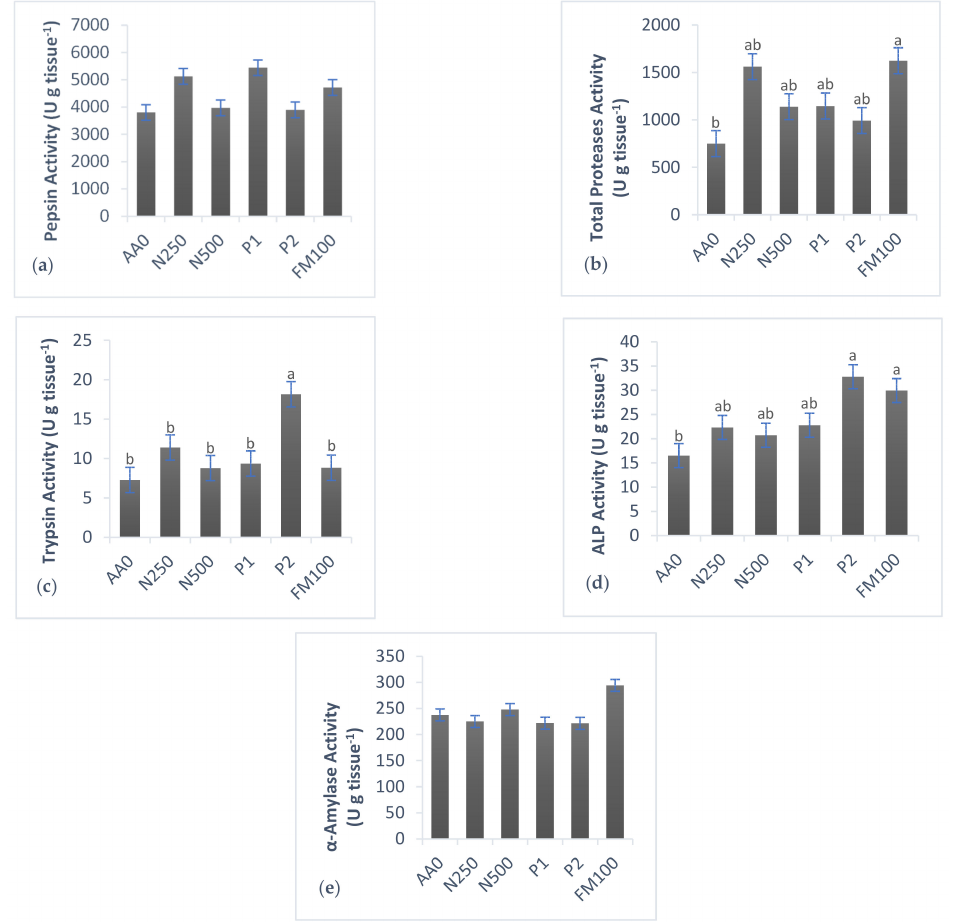
Figure 1. Digestive enzyme activity expressed in U g tissue − 1 and determined in the gastrointestinal tissue of fish fed the different experimental diets. ( a ) Pepsin activity in stomach tissue; ( b ) total alkaline proteases activity in gut tissue; ( c ) trypsin activity in gut tissue; ( d ) alkaline phosphatase (ALP) activity in gut tissue; ( e ) α -amylase activity in gut tissue. Means of three fish per treatment ± SEM ( n = 9). Different superscripts indicated differences ( p <